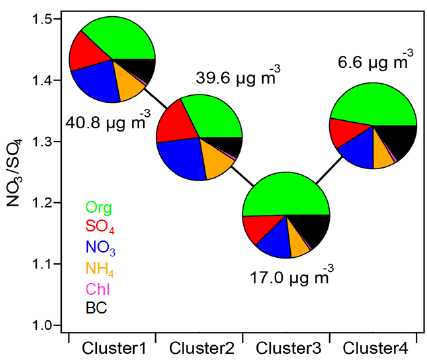
Figure 8. Nitrate / sulfate mass ratios for each cluster. The pie charts represent the average PM 1 chemical composition of the dif- ferent clusters. The total PM 1 concentrations for each cluster are also